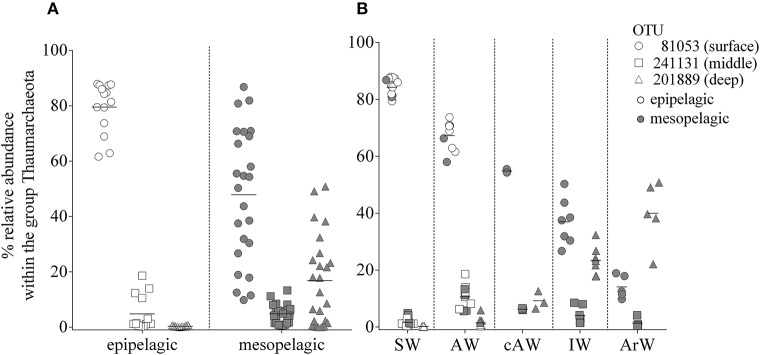
(A) Relative abundance of the three most abundant Thaumarchaeota OTUs. Samples were divided according to their sampling origin in epipelagic (open symbols; 0–200 m; n = 16) and mesopelagic (filled symbols; 200–1,000 m; n = 22) zones. (B) Same data as in (A), grouped according to assigned water masses based on sample similarities illustrated in Figure 3. ArW, Arctic Water; SW, Surface Water; AW, Atlantic Water; cAW, cold Atlantic Water; IW, Intermediate Water.